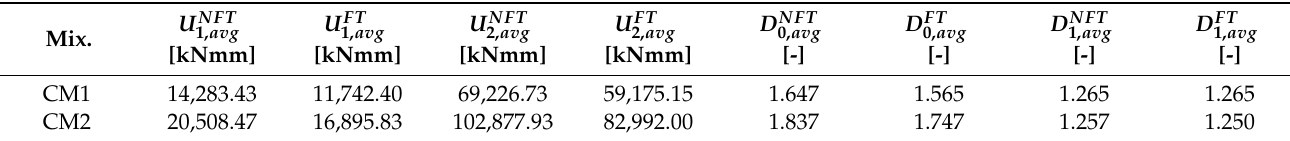
cycles for the two types of HPFRC mixture (CM1 and CM2). Table 2. The average values of the work capacity indices, U (1, avg ) and U (2, avg ) , and ductility indices, D (0, avg ) and D (1, avg ) , before (NFT) and after the freeze–thaw cycles (FT) for the two types of HPFRC mixture (CM1 and CM2).